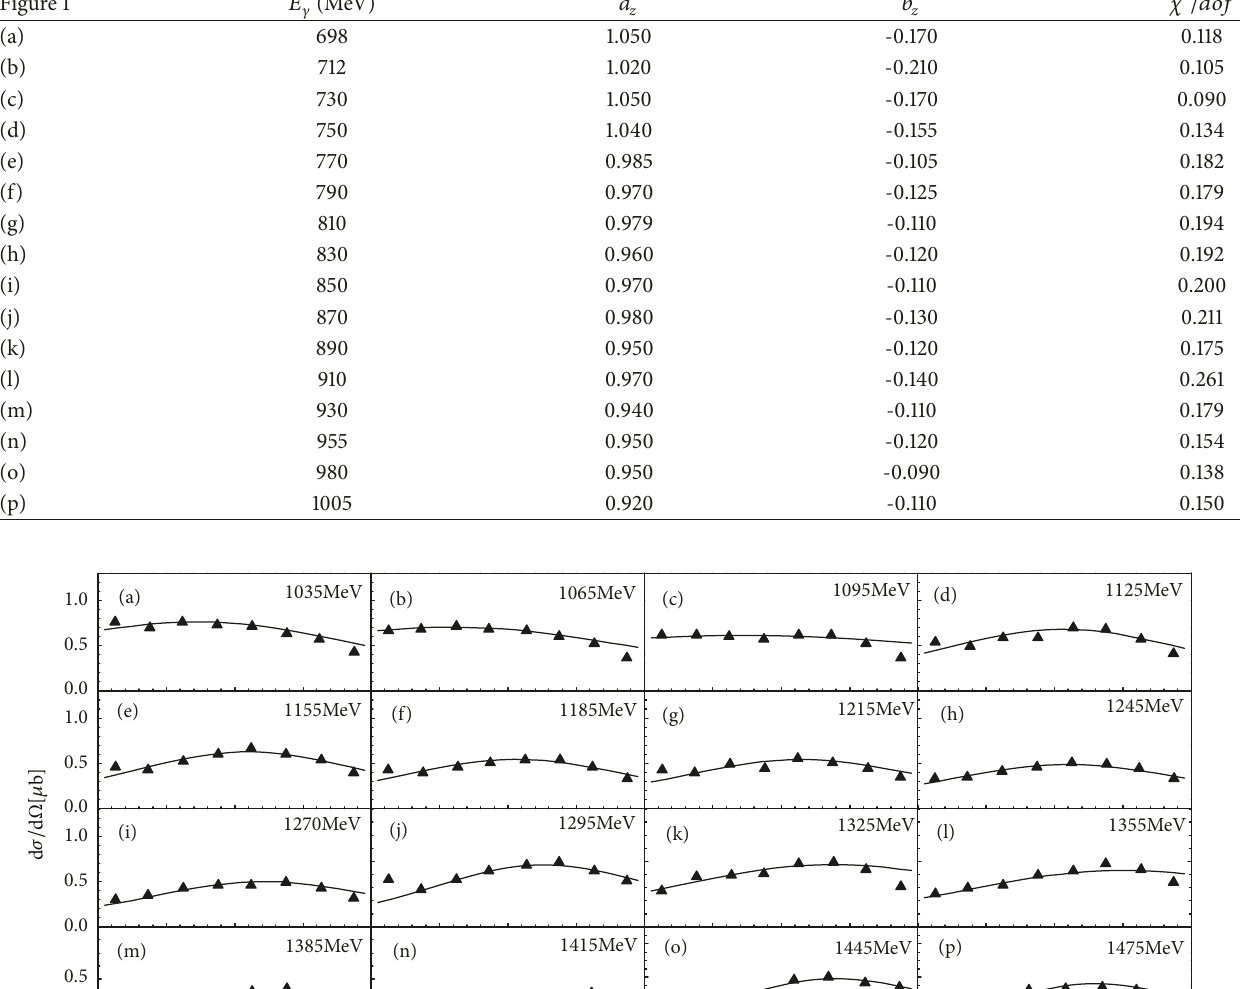
Table 1: Values of 𝑎 𝑧 and 𝑏 𝑧 taken in Figure 1 model results.